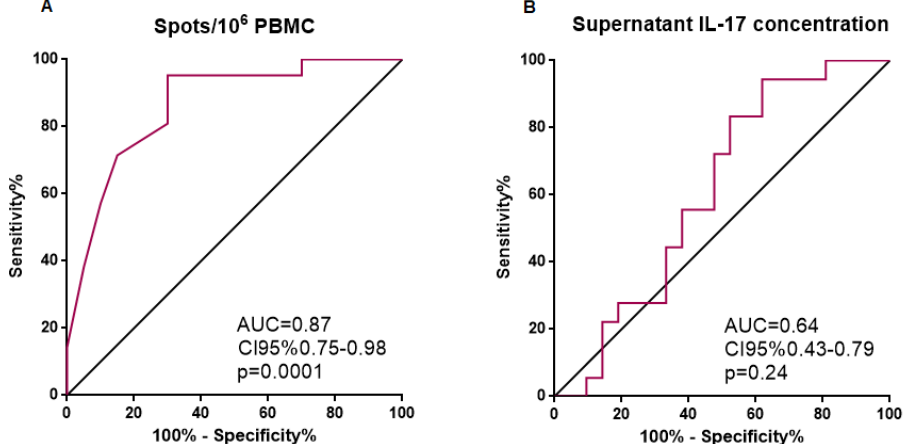
Figure 2. Receiver operator curves of number of spots/10 6 PBMCs and supernatant IL-17 concentration. ( A ) Number of spots/10 6 PBMCs showed a good performance as a disease activity biomarker, as reflected by AUC = 0.87 (CI 95%: 0.75–0.98). ( B ) Supernatant IL-17 did not perform well as a disease activity biomarker. PBMCs—peripheral blood mononuclear cells; IL-17—interleukin-17; AUC—area under the curve; CI—confidence